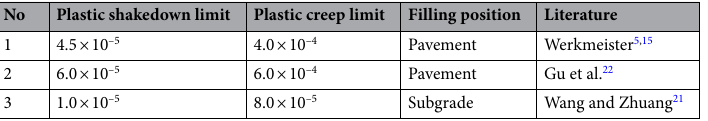
Table 1. The shakedown and creep limits determined by Δ ε p ,5000 − Δ ε p ,3000 from different